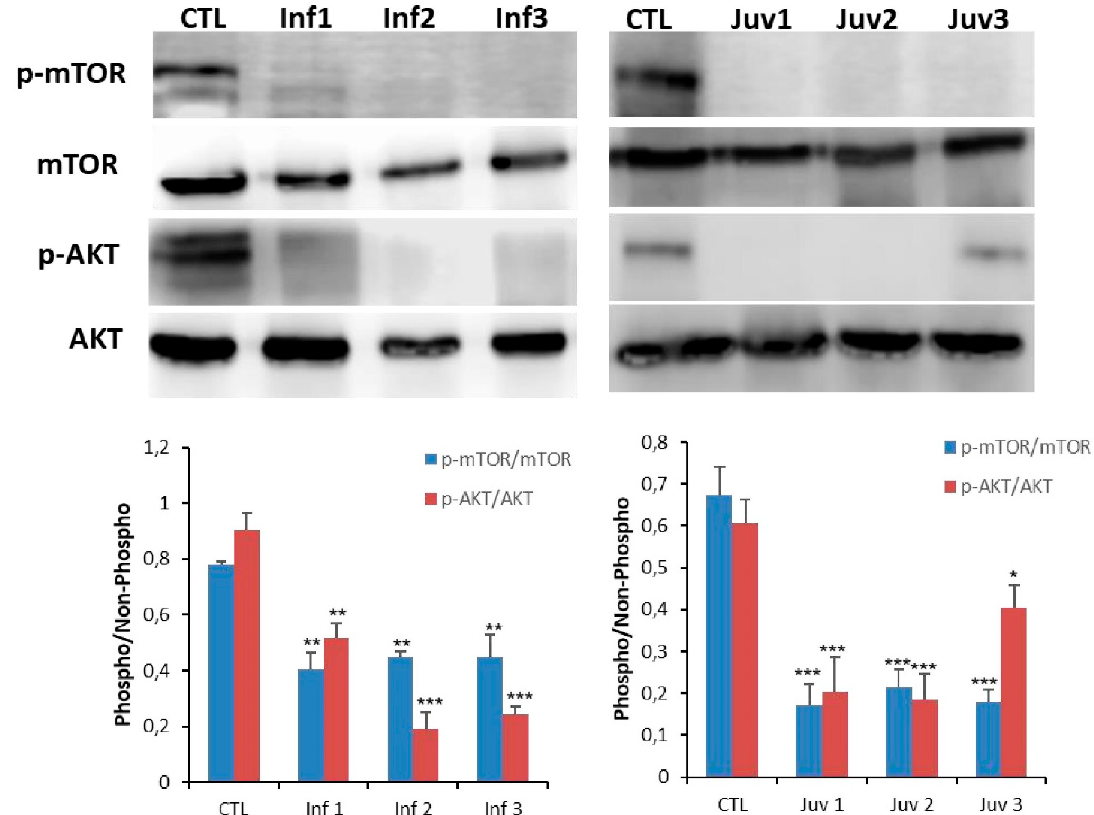
Figure 4. Expression of mTOR and AKT protein were determined in cultured control and Tay–Sachs disease fibroblasts. Data represent the mean ± SD of three separate experiments.* p < 0.05; ** p < 0.01; *** p < 0.001 between transfected and non ‐ transfected cells.